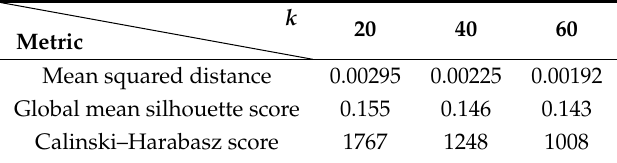
Table 1. Clustering metrics with different numbers of